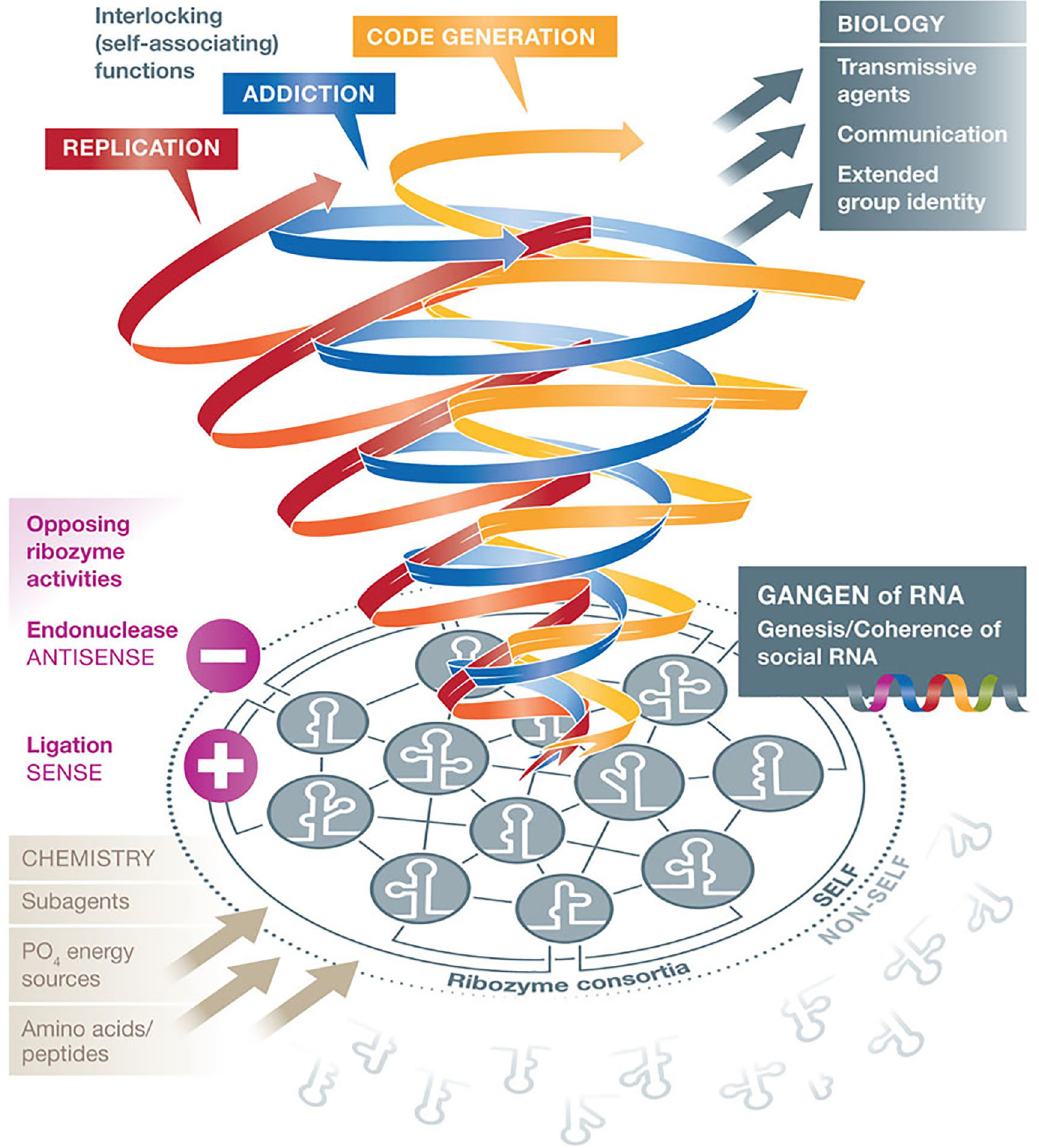
Figure 1. The RNA “ gangen ” hypothesis: RNA stem-loop groups assemble like social gangs. According to Villarreal, group identity and cooperativity of an RNA collective require opposing functions which are essential for the genesis of life (social behavior of agents). Interestingly, at the very beginning of the RNA world, ribozyme consortia with group identities initiated the differentiation competence of “ self ” from “ non-self ” , like “ gangs ” , according to dynamically varying contextual requirements. Figure 1 assembles all key topics: abiotic – biotic interac- tions, consortial life and identity building, inclusion – preclusion, opposing ribozyme activities (endonuclease – ligase), basics of cell biology and code emergence out of interactions. The red arrow flow represents all the RNA mediated regulations necessary in replication steps, the blue arrow represents all RNA mediated regulations integrating two competing genetic parasites into the host genome ( “ addiction module ” ), and the yellow arrow designates all RNA mediated interactions leading to the emergence of the genetic code (from Villarreal, 2015; with permission by the New York Academy of 2.1 Ligated RNA stem-loop groups: the ribosome The self-ligation of different parts of RNA stem-loop groups occurs at single-stranded RNA parts (Gwiazda et al ., 2012). Here, it is important to note that circular RNAs are protected against endonuclease degradations and therefore represent Rivera-Madrinan, Di Iorio, & Higgs, 2022). With the emergence of the RNA polymerase ribozyme, functional RNA